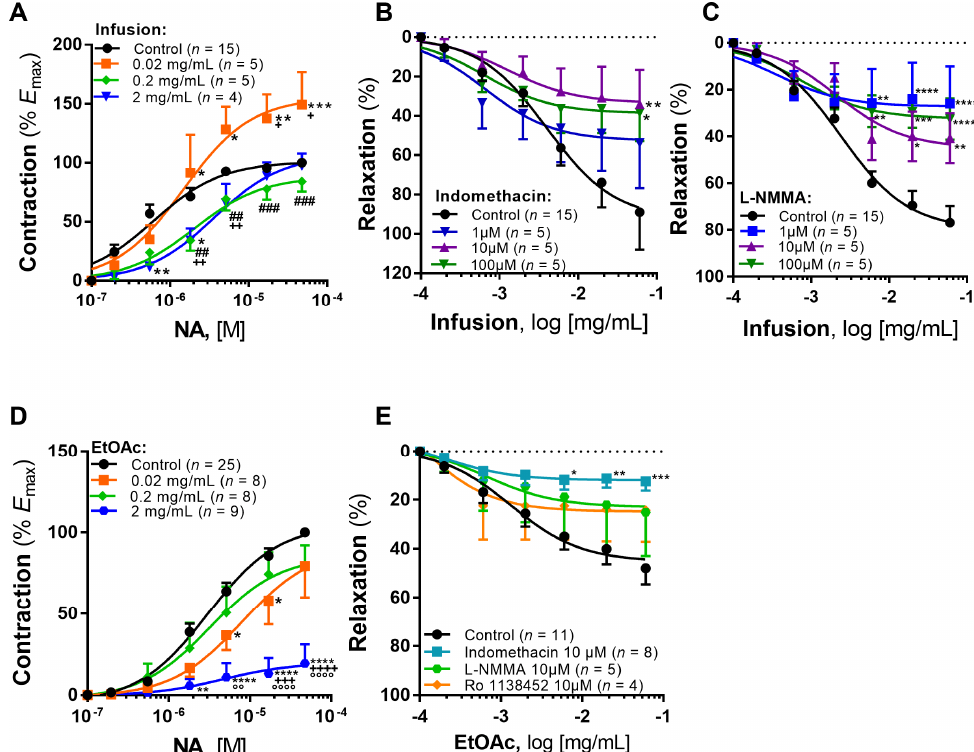
Figure 2. Vascular activity of the infusion ( A – C ) and EtOAc fraction ( D – E ) of A. eupatoria . Infusion: ( A ) Effect on the noradrenaline-induced contraction; * p < 0.05 vs. control, ** p < 0.01 vs. control, *** p < 0.001 vs. control, ## p < 0.01 vs. 0.2 mg/mL, ### p < 0.001 vs. 2 mg/mL, + p < 0.05 vs. 2 mg/mL, ++ p < 0.01 vs. 2 mg/mL. ( B ) Influence of COX blocking with indomethacin on the vasorelaxation to the infusion; * p < 0.5 vs. control, ** p < 0.01 vs. control. ( C ) Influence of endothelial nitric oxide synthase blocking with L-NMMA on the vasorelaxation to the infusion; * p < 0.05 vs. control, ** p < 0.01 vs. control, *** p < 0.001 vs. control, **** p < 0.0001 vs. control. Significance refers to unpaired two-way analysis of variance (ANOVA) with Tukey’s multiple comparisons test. EtOAc fraction: ( D ) Effect on the noradrenaline-induced contraction; * p < 0.05 vs. control, ** p < 0.01 vs. control, **** p < 0.0001 vs. control, +++ p < 0.001 vs. 2 mg/mL, ++++ p < 0.0001 vs. 2 mg/mL, °° p < 0.01 vs. 2 mg/mL, °°°° p < 0.0001 vs. 2 mg/mL. ( E ) Influence of COX blocking with indomethacin, endothelial nitric oxide synthase blocking with L-NMMA and blocking PGI 2 receptors with a selective antagonist Ro 1138452 on the vasorelaxation to EtOAc fraction; * p < 0.05 vs. control, ** p < 0.01 vs. control, *** p < 0.001 vs. control. Table 2. Pharmacological parameters from vascular activity studies with A. eupatoria infusion.